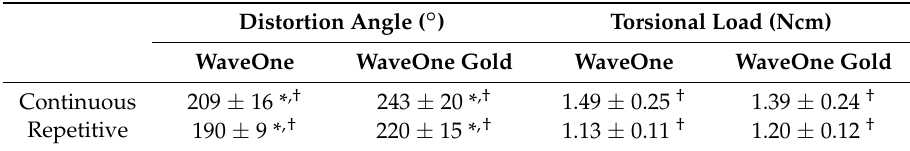
* Asterisk superscript symbol indicates significant difference between WaveOne and WaveOne Gold groups ( p < 0.05). † Obelisk superscript symbol indicates significant difference between